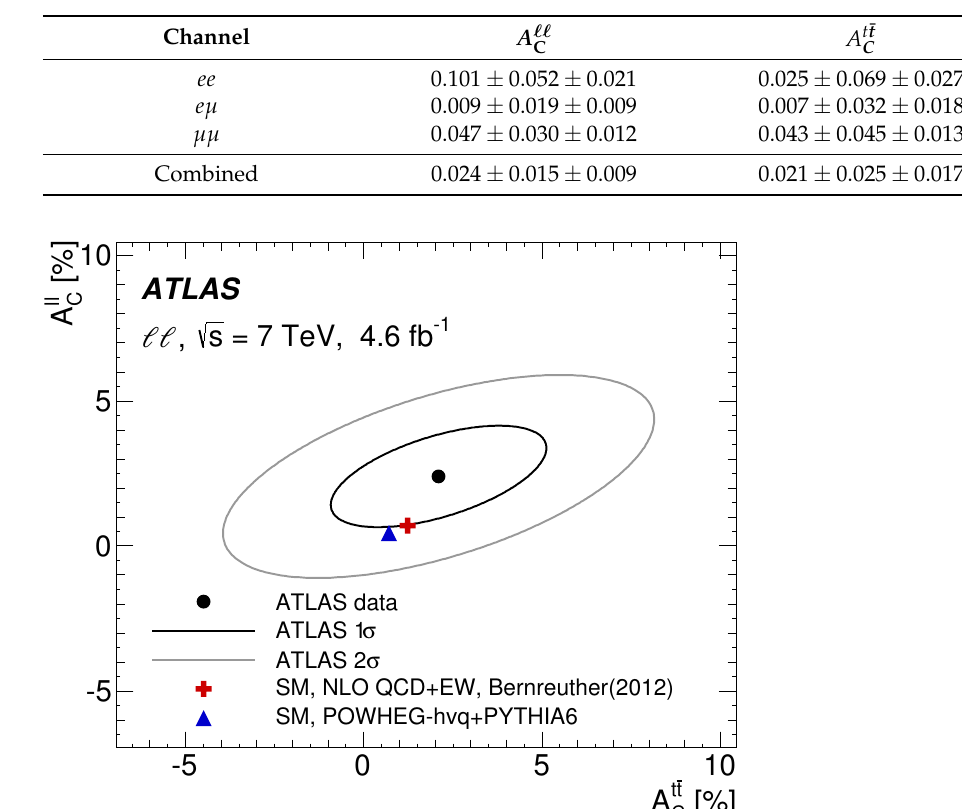
Figure 3. Comparison of the inclusive A (cid:96)(cid:96) (SM NLO QCD+EW prediction [14]) and the prediction of the POWHEG-hvq + PYTHIA genera- tor. Ellipses corresponding to 1 σ and 2 σ combined statistical and systematic uncertainties of the measurement, including the correlation between A (cid:96)(cid:96)